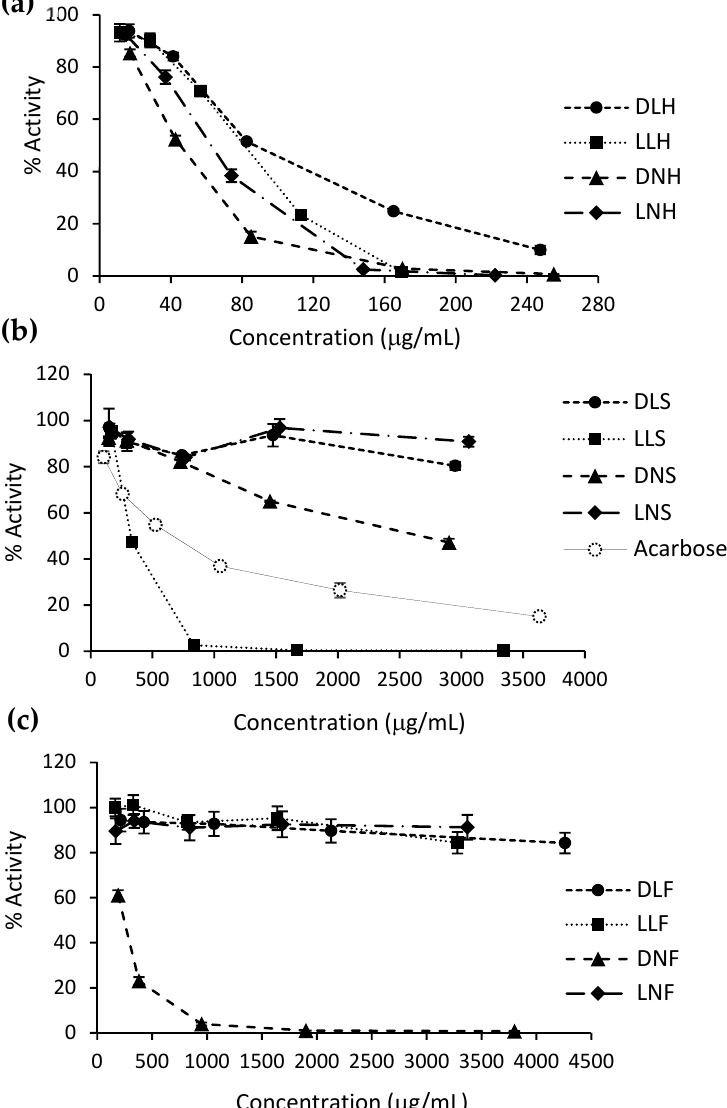
Figure 3. α -glucosidase inhibitory activity of D. incurvata and L. spicata PHLE extracts. The charts present the relative enzyme activity against increasing concentrations of extracts, classified by the seaweed part origin: ( a ) holdfast, ( b ) stipe, and ( c ) frond. The acarbose inhibitory curve is also shown. Data are means ± SD of two replicates.